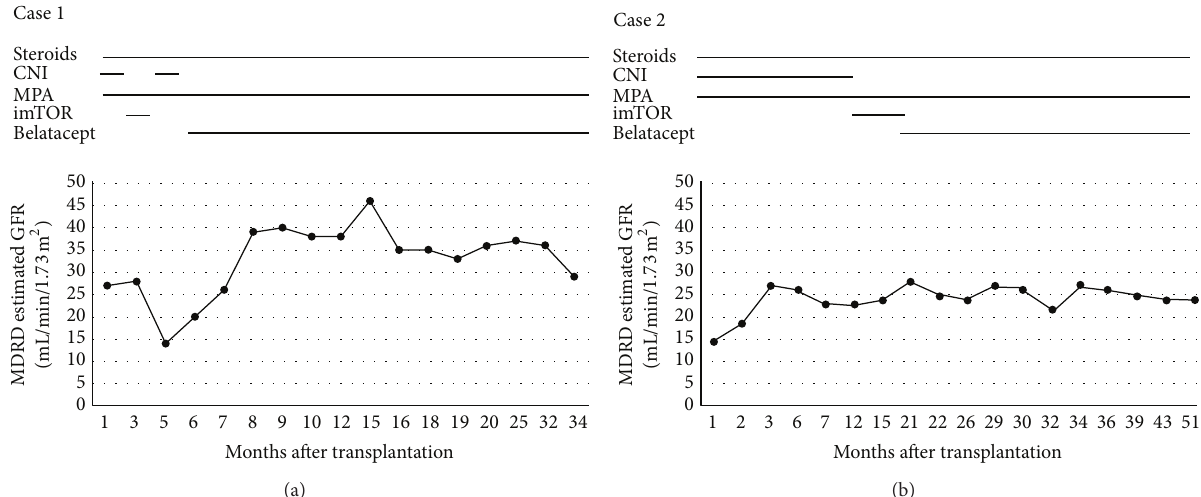
Figure 1: Kidney function. Glomerular-filtration rate (GFR) values were estimated with MDRD and reported for each case according to the